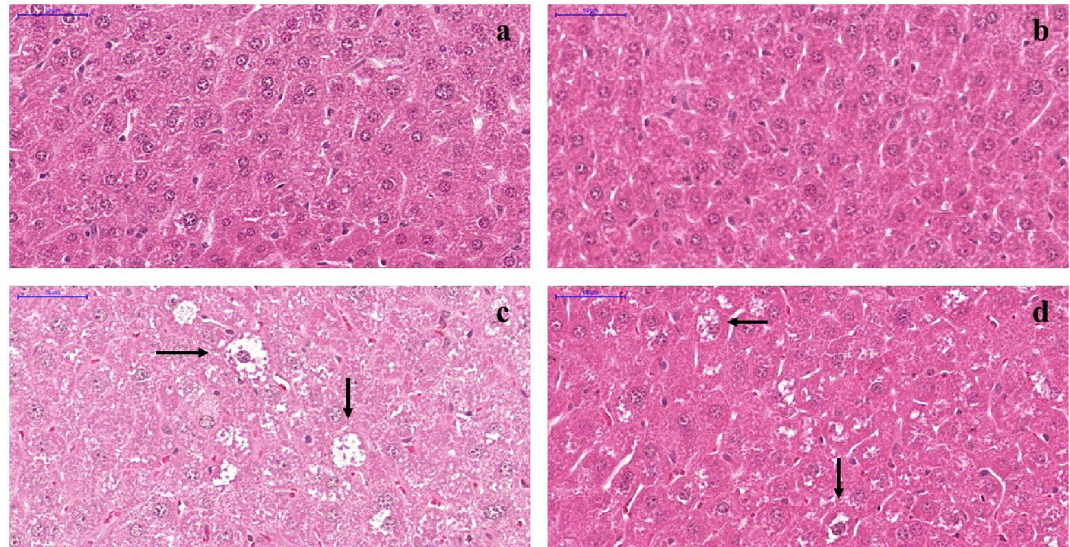
Figure 5. Histological sections of liver stained with Hematoxylin & Eosin from C57BL/6 STZ-induced diabetic mice, + /- Saccharomyces boulardii (0.5 × 10 8 colony-forming units, THT 500,101 strain , Probiotics and Starters Cultures, Belgium) for 8 weeks. Control (a) and Control treated with S. boulardii (b) show normal hepatocytes organization. The diabetic group (c) showed hepatocytes with signs of hydropic degeneration which consists in enlarged cells and clear cytoplasm due to the presence of small clear vacuoles with indistinct shape and limits ( → ), and in diabetic group treated with S. boulardii (d) it is attenuated.